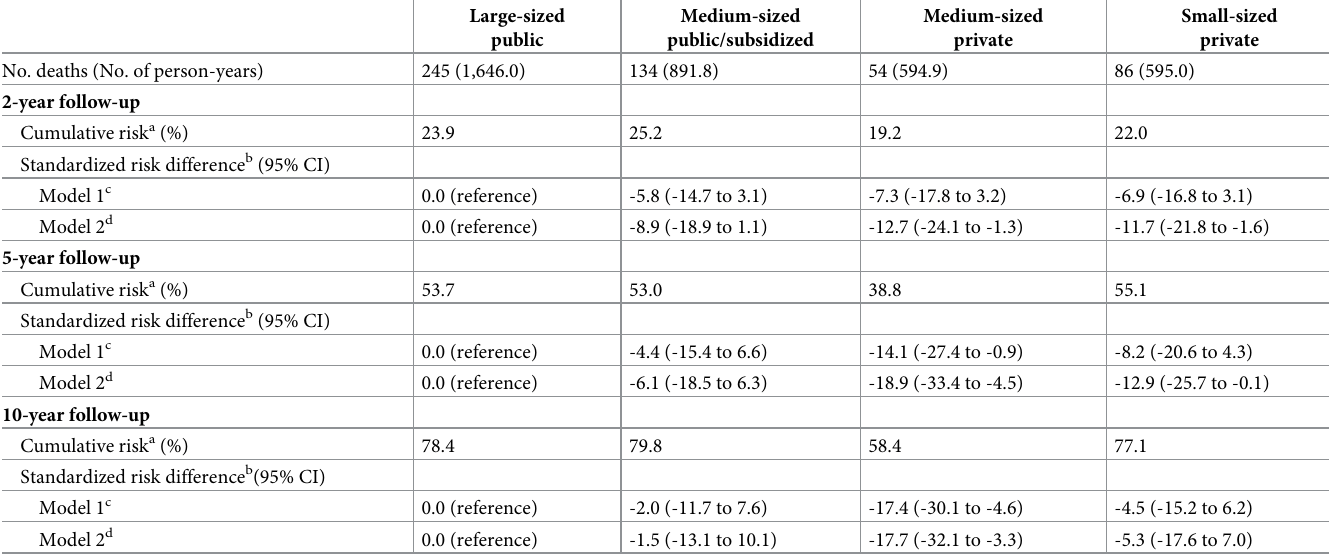
Table 2. Standardized differences in cumulative all-cause mortality at 2, 5, and 10 years of follow-up by type of facility among institutionalized residents in Madrid, Spain 1998–1999 to 2013.